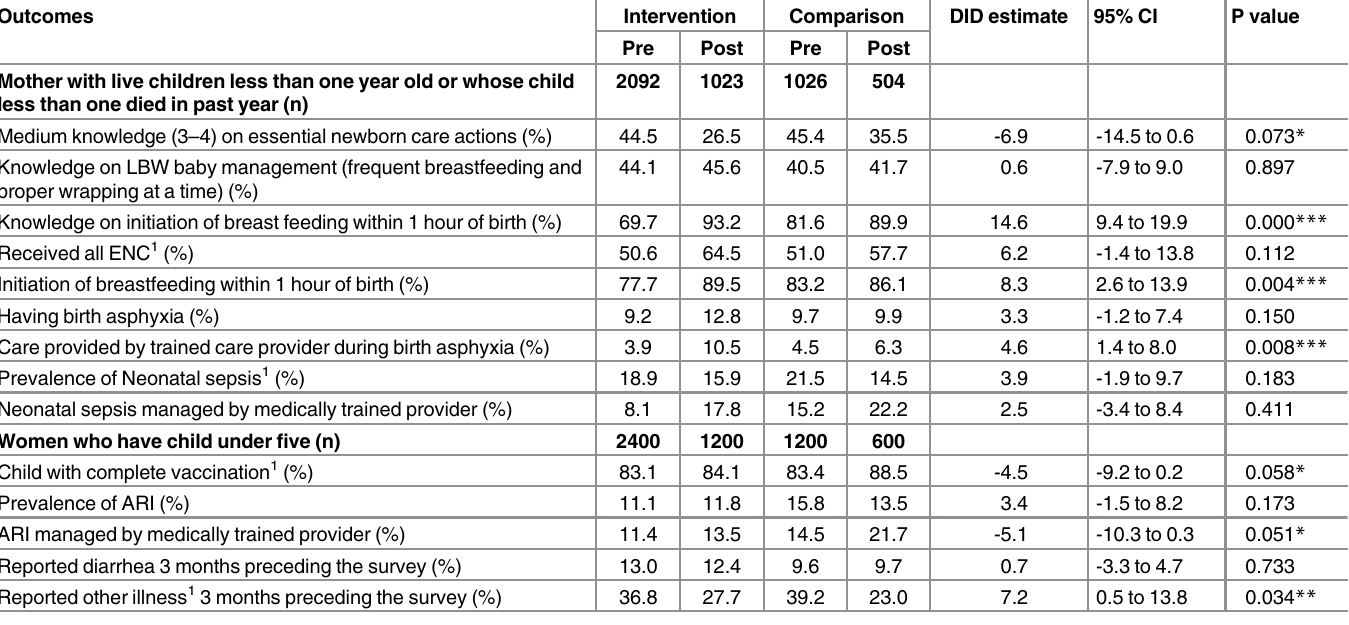
Table 4. DID analysis of the impact of the IMNCS intervention on infant and child health